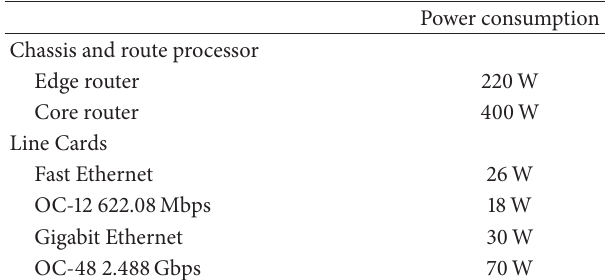
Table 1: Values of power consumed by the physical router compo-